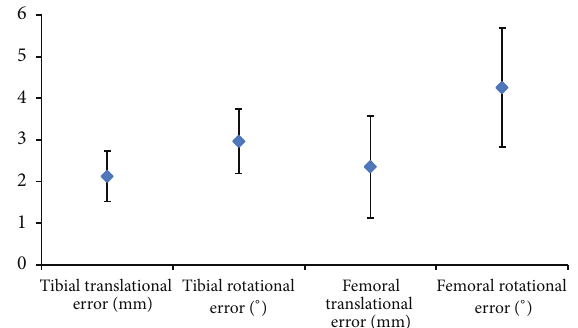
Figure 2: Magnitude of resultant rotational and translation error for tibial and femoral components when compared to planned posi-